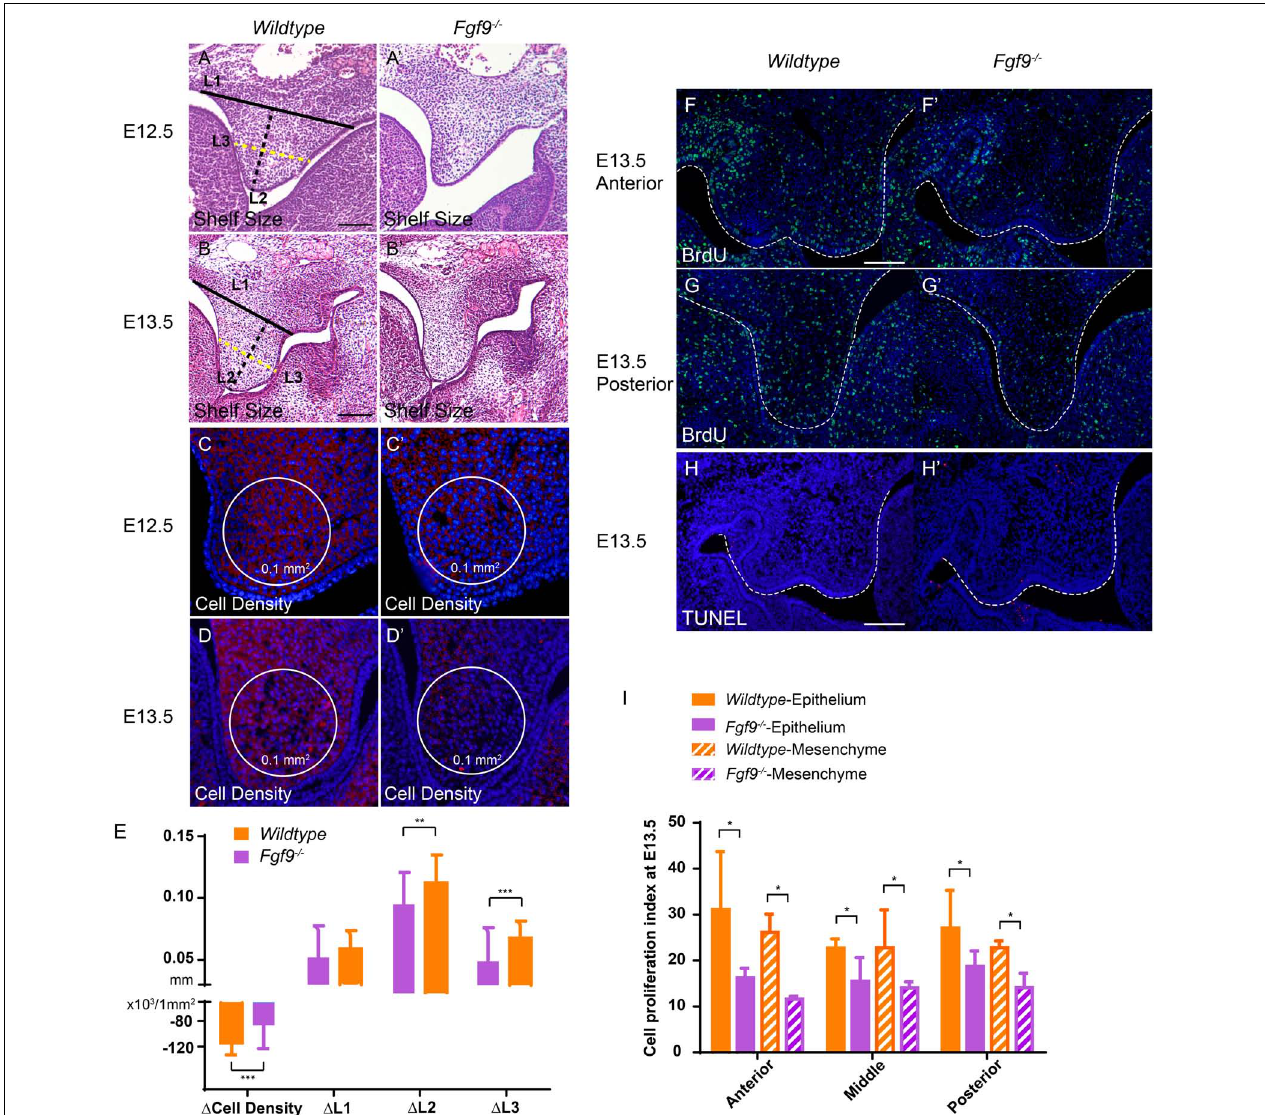
FIGURE 6 | Fgf9 − / − palatal shelves exhibit attenuated size increase and cell density decrease from E12.5 to E13.5. Selected serial sections of the anterior ( n = 7), middle ( n = 8), and posterior ( n = 5) of the embryonic heads from three litters were measured. HE staining shows smaller palatal shelves in the Fgf9 − / − embryos than the Wildtype littermates at (A,A’) E12.5 and (B,B’) E13.5. L1, L2, and L3 are shorter in the Fgf9 − / − embryos. Cell density was higher in the Fgf9 − / − embryos than the Wildtype littermates at (C,C’) E12.5 and (D,D’) E13.5. L1, L2, and L3 were shorter in the Fgf9 − / − embryos. The cell density and palatal shelf size of Fgf9 − / − embryos exhibited attenuated reduction and less growth, respectively (E) . Coronal sections with BrdU immunofluorescence through (F,F’) anterior and (G,G’) posterior regions of Wildtype and Fgf9 − / − embryos at E13.5. Coronal sections with TUNEL assays of (H) Wildtype and (H’) Fgf9 − / − embryos at E13.5. (I) Quantification of cell proliferation index through anterior, middle, and posterior regions in the epithelium and mesenchyme of the Wildtype and Fgf9 − / − embryos at E13.5. Full lines, black dotted lines, and yellow dotted lines indicate the width (L1), length (L2), and 1/2 width (L3) of palatal shelves, respectively. * P < 0.1, ** P < 0.05, *** P < 0.001. Scale bars = 100 µ